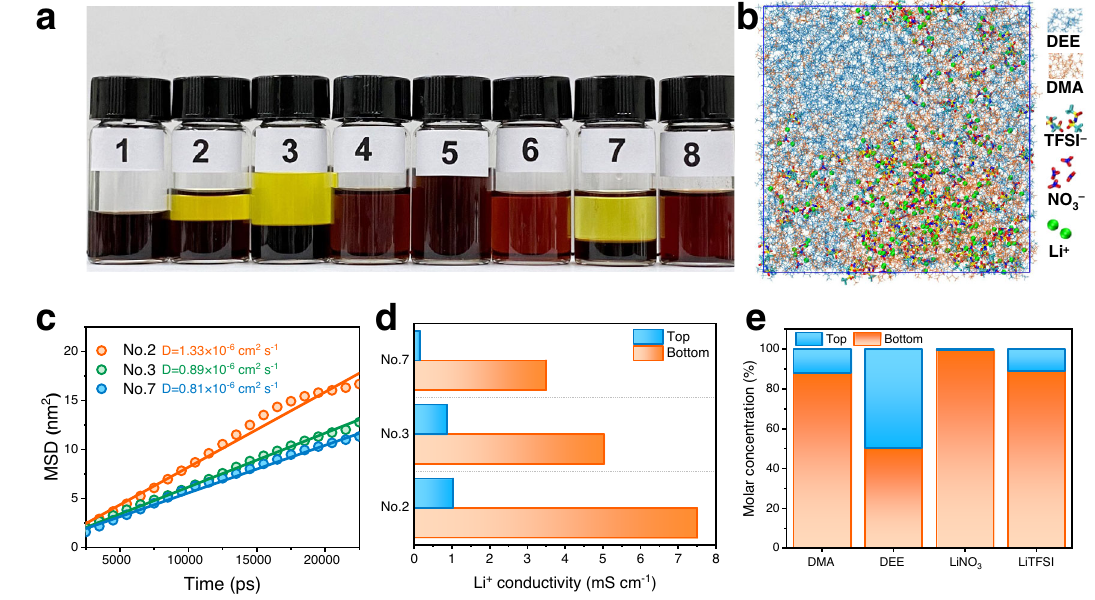
Fig. 2 | Design considerations of Li-S BSBs. a Phase separation of DMA-DEE sys- tems with different amounts of LiTFSI and LiNO 3 . The color is from the pigment dissolved in them. b Snapshot of the MD simulation of No. 2 system showing apparent phase separation behavior. c Calculated MSD of Li + in the three biphasic